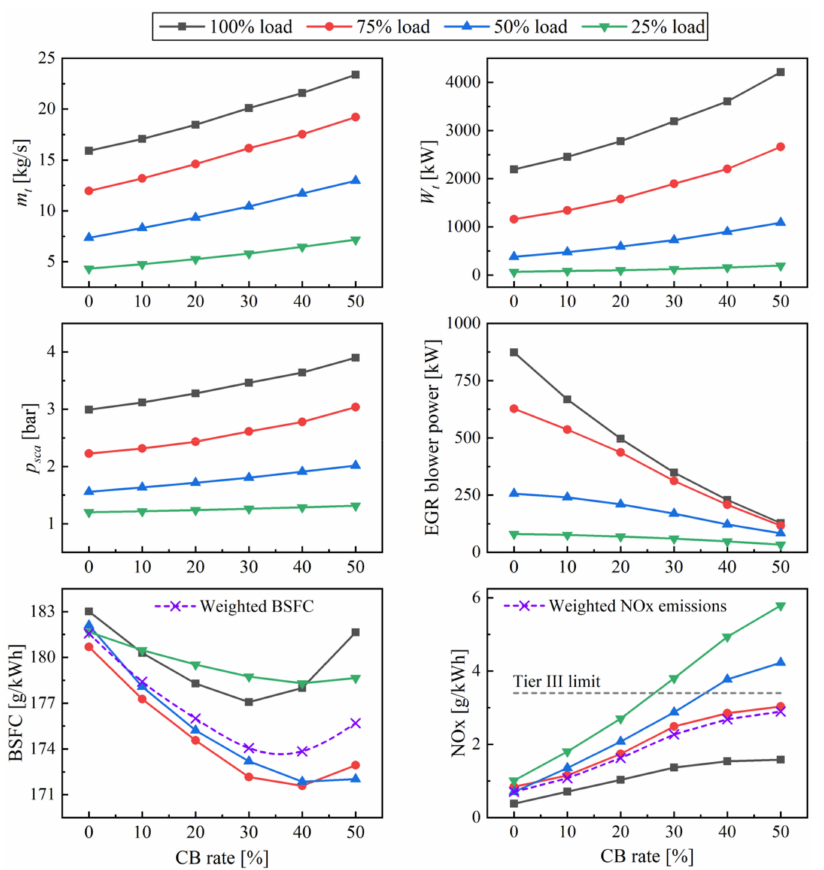
Figure 8. CB rate impact on engine performance and power consumption of an EGR blower for the BL-EGR engine configuration with 40% EGR